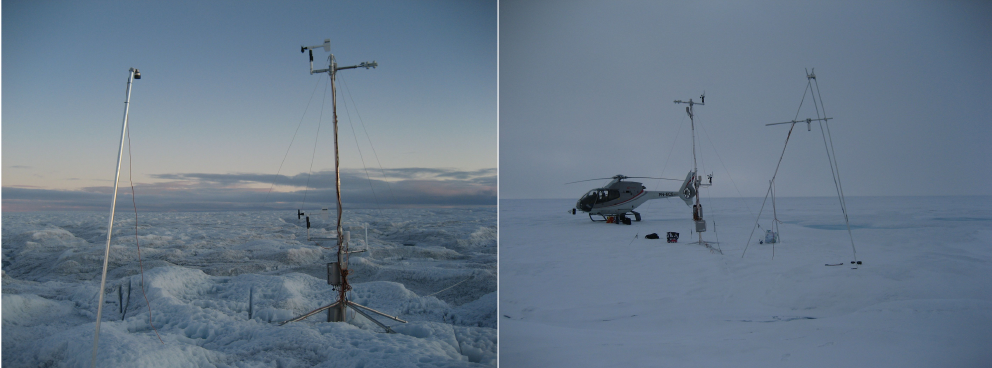
Fig. 2. Automatic weather stations along the K-transect in West Greenland. On the left S6, on the right S9. For locations see Fig. 1. The photographs were taken at the end of August 2011.